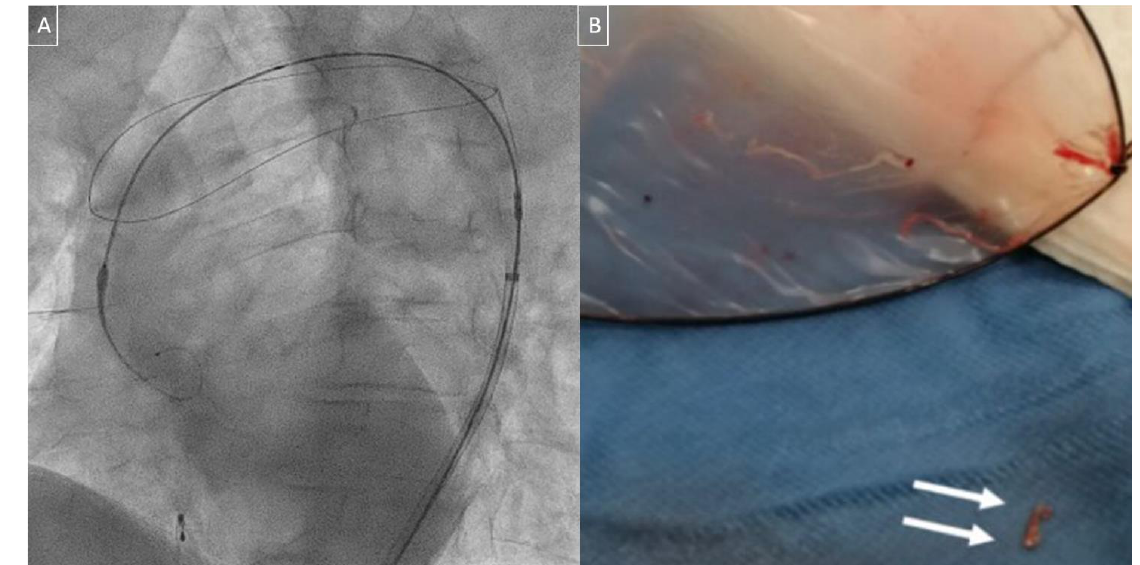
Figure 3. TriGuard™ cerebral protection device used in a patient with a bicuspid aortic valve during transcatheter aortic valve implantation (TAVI) ( A ) and the debris captured ( B ).